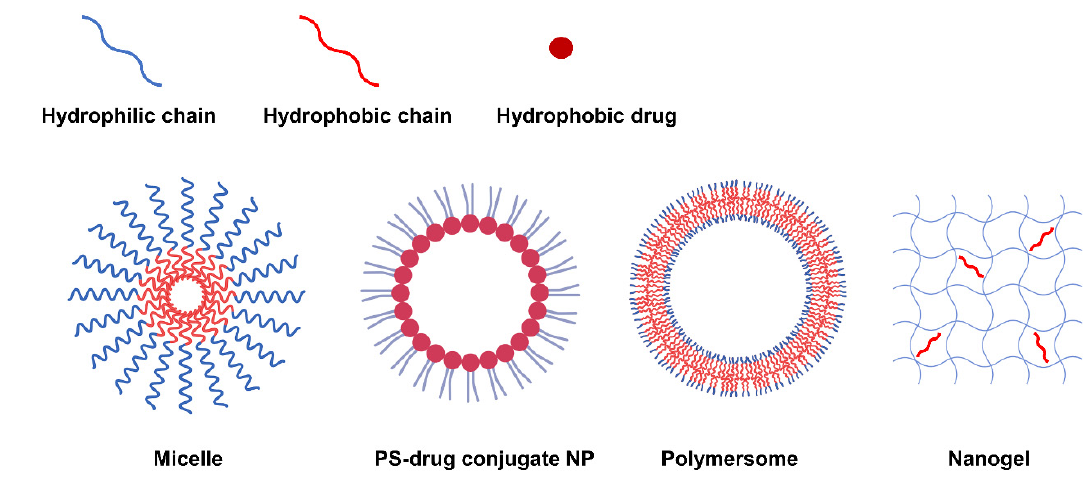
Figure 2. Representative types of NPs classified according to nanostructure.